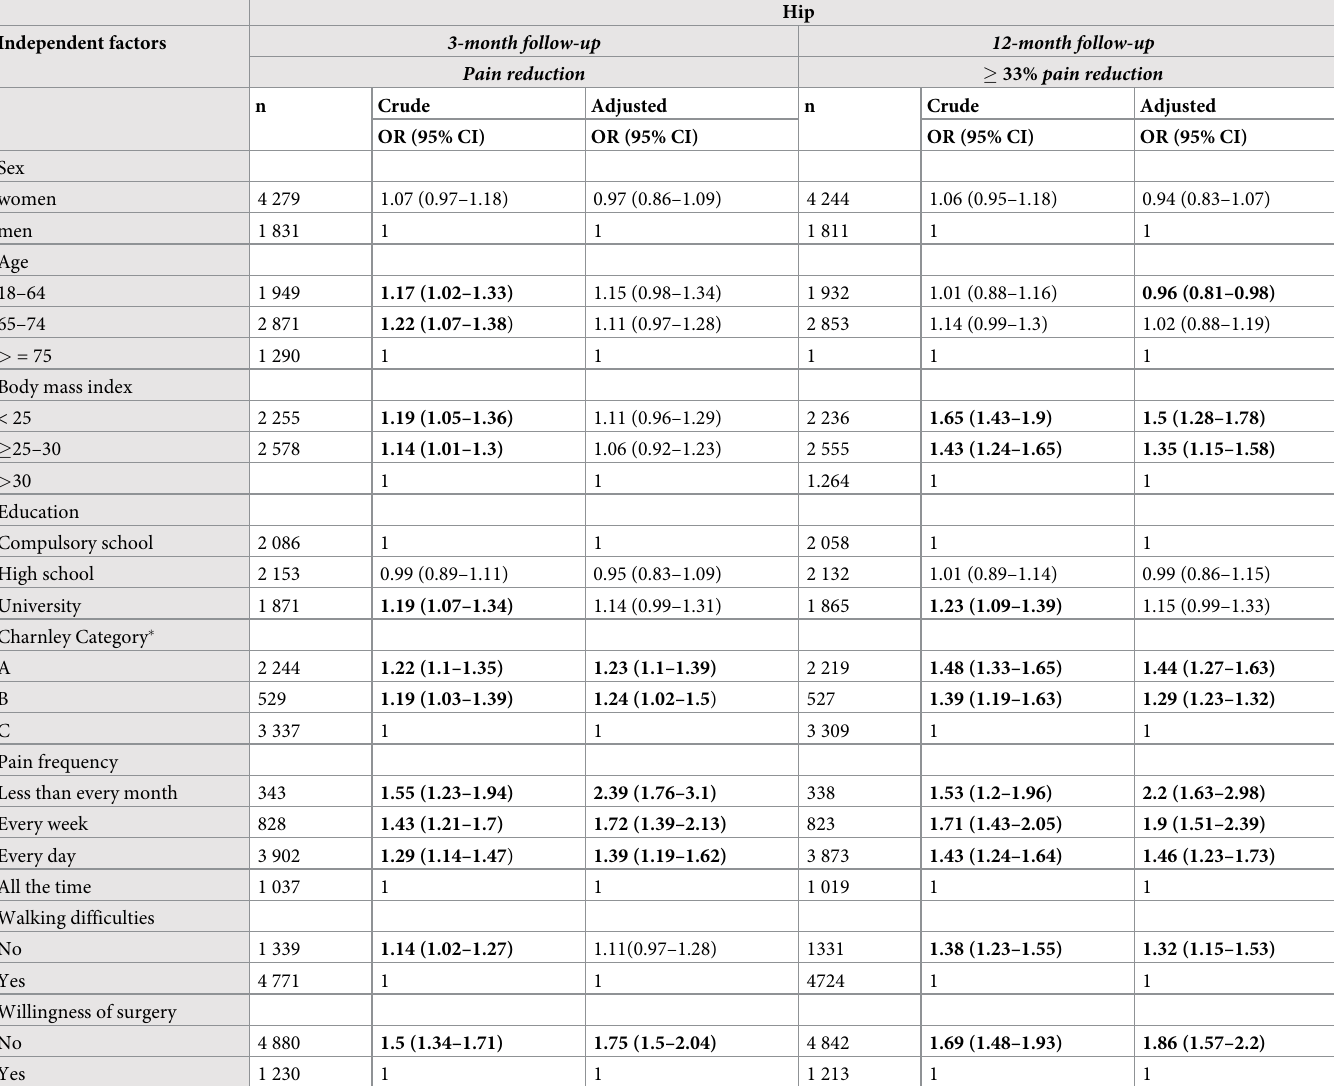
Table 4. Factors associated with reaching a clinically relevant pain reduction at 3- and 12-month follow-up in people with hip